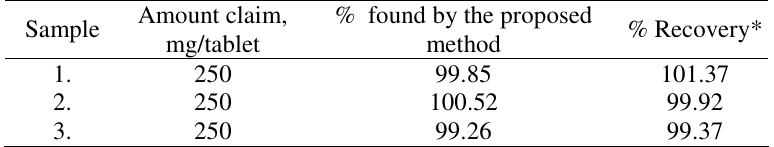
Table 2. Results of HPLC assay and recovery studies